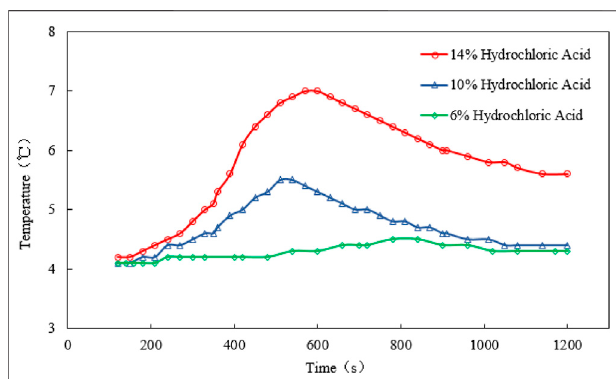
FIGURE 5 | Temperature vs. time at different HCl concentrations.